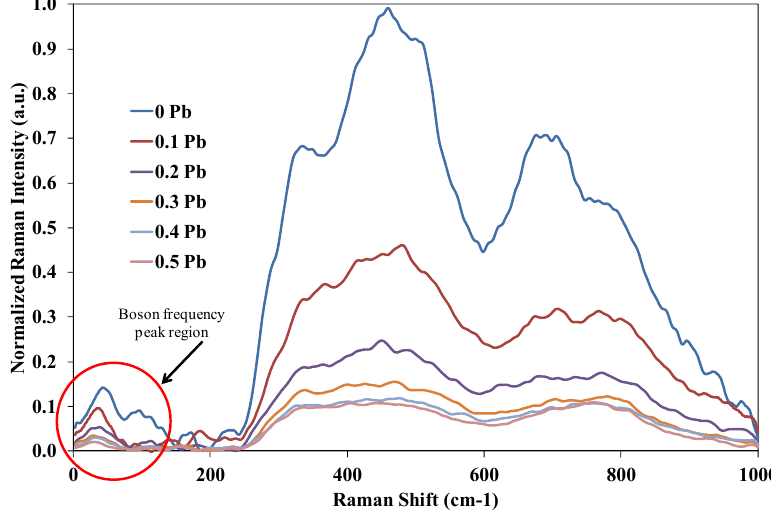
) [(PbO) (B O ) ] glasses 2 y x 2 3 1 − x 1 − y